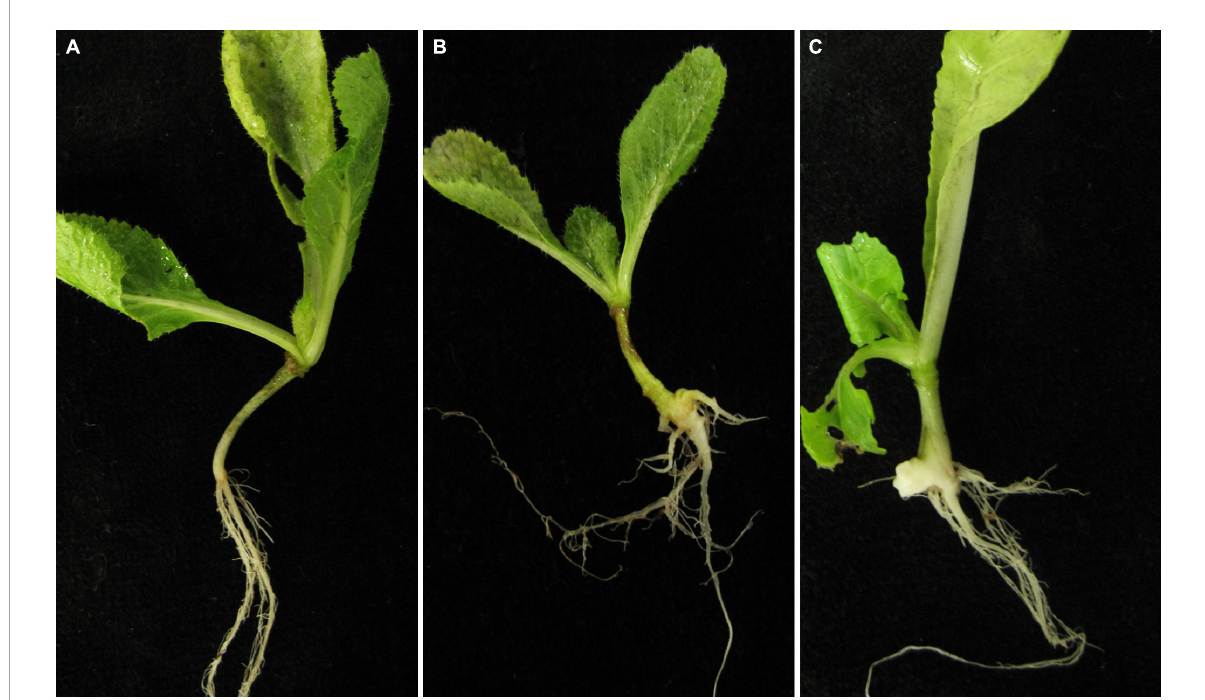
FIGURE1 Symptoms of cabbage roots inoculated with primary and secondary zoospores. (A) Control, (B) symptoms of cabbage roots with secondary zoospore inoculation after 40 days, and (C) symptoms of cabbage roots with primary zoospore inoculation after 40